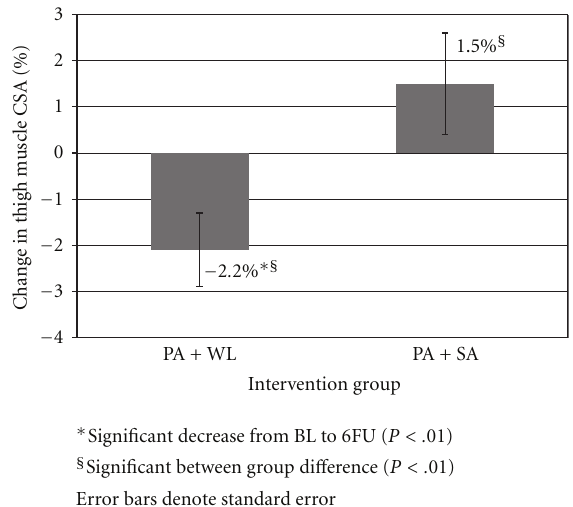
Figure 3: Percent change in total thigh muscle CSA from baseline to 6-month followup by intervention